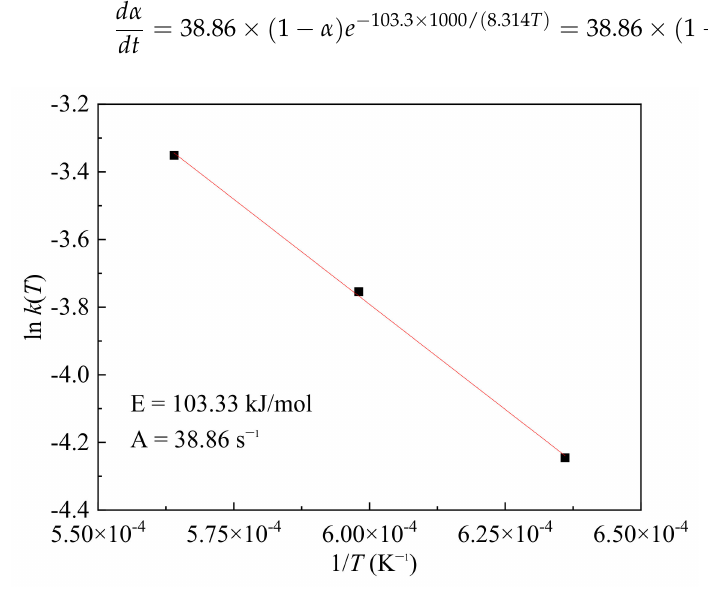
Figure 13. Linear fitting of ln k ( T ) and 1/ T